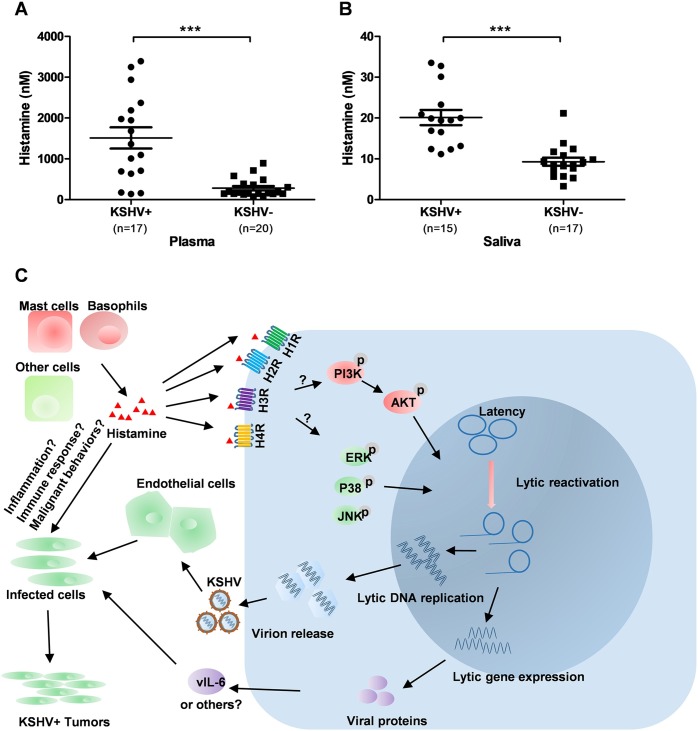
Elevation of histamine production in KSHV+ HIV-infected patients.(A-B) The histamine concentrations within plasma or saliva from cohort HIV-infected patients were quantified using ELISA. KSHV infection status was identified as described in Methods. *** = p<0.0001. (C) Proposed schematic representation of histamine related signaling promoting KSHV lytic reactivation, replication as well as viral pathogenesis.